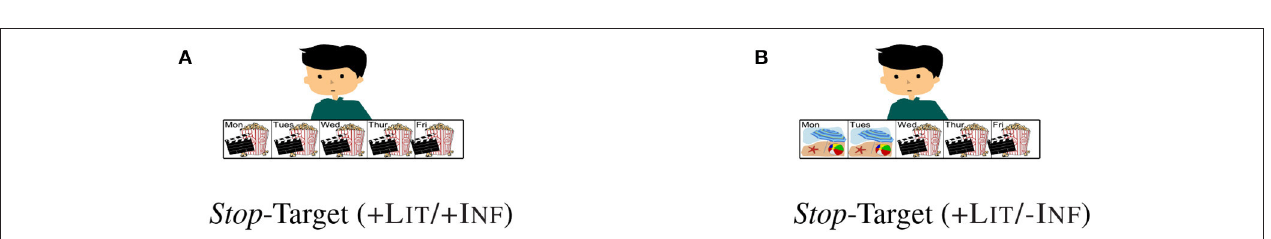
FIGURE 1 | Target pictures for always conditions, matched with a sentence like (38): “ + L IT / + I NF ” (A) and “ + L IT / − I NF ” (B) .